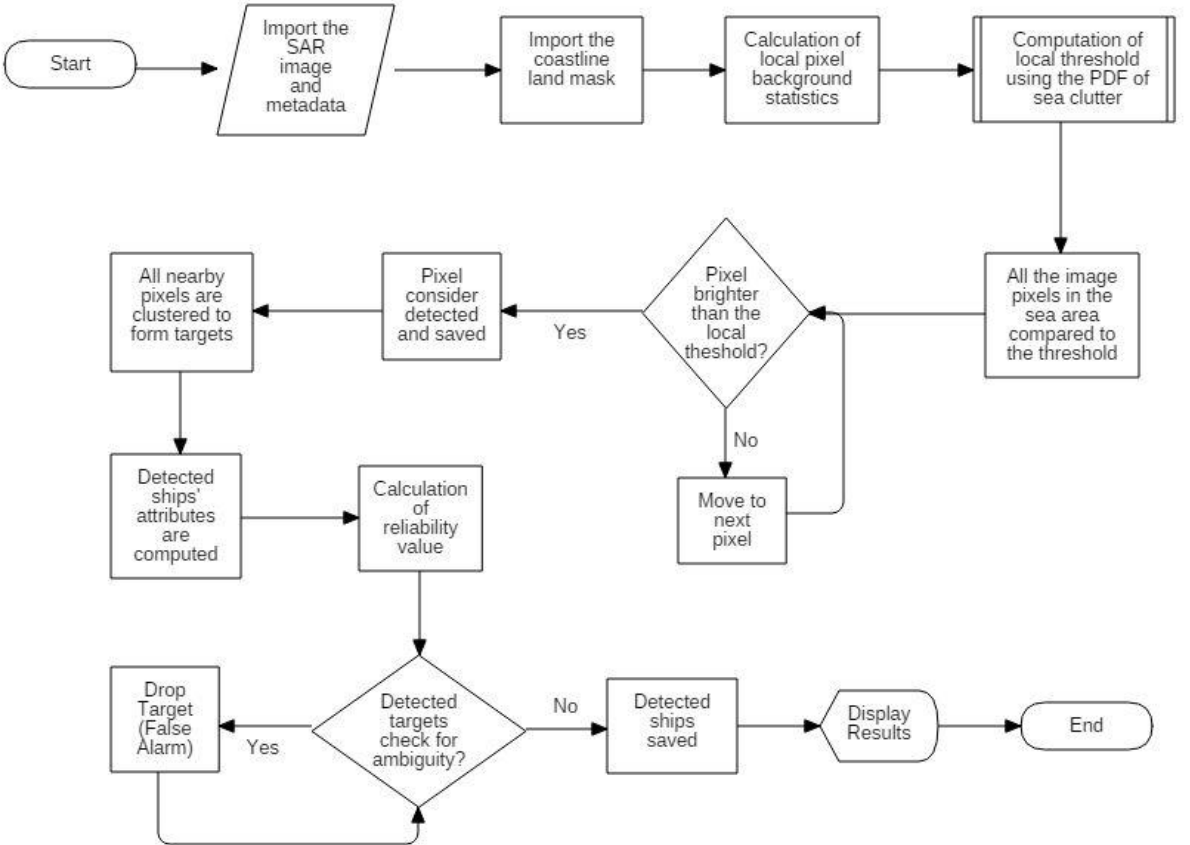
Figure 1. The flow diagram of ship detection and identification by